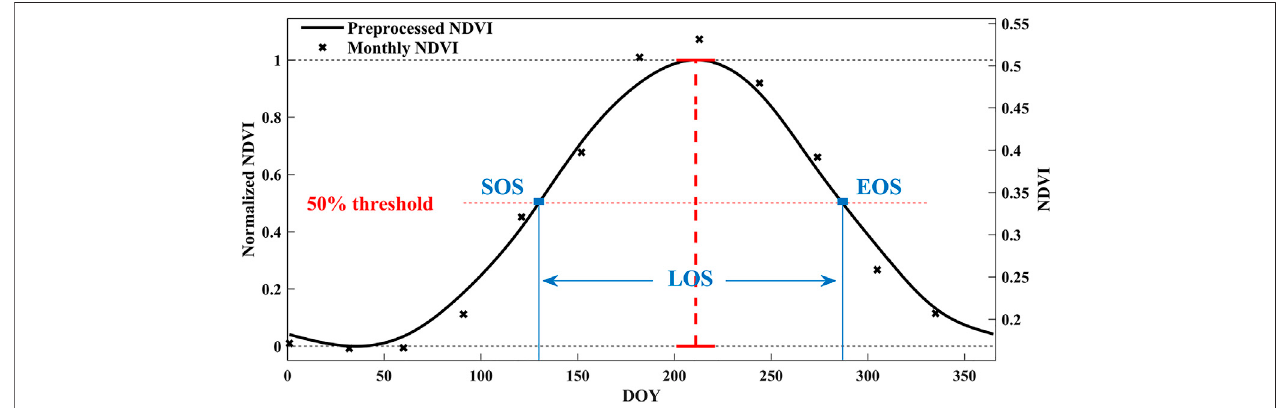
FIGURE 2 | The method of estimating phenological characteristics. The “ × ” points are original data. The black solid line is a preprocessed seasonal curve that has beensmoothed,interpolated,andnormalized.Theredhorizontaldottedlineisthe50%thresholdofmaximumandminimumofthepreprocessedseasonalcurve(thered vertical dotted line). The blue square dots are the SOS and EOS, and LOS is the difference between SOS and